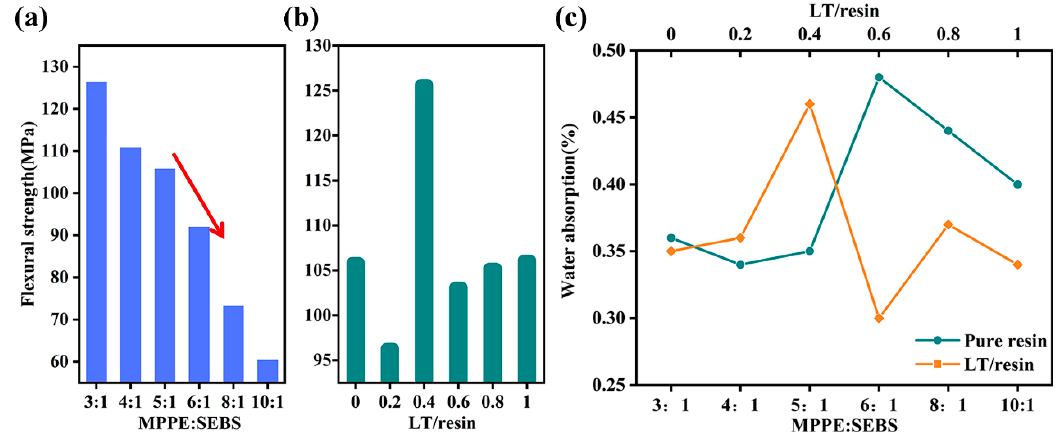
Figure10. Flexuralstrengthof( a )P-CCLsand( b )LT-CCLs; ( c )waterabsorptionofP-CCLsandLT-CCLs. Figure 10. Flexural strength of ( a ) P-CCLs and ( b ) LT-CCLs; ( c ) water absorption of P-CCLs and LT- CCLs. Table 2. Comparison of properties of polymeric composites.